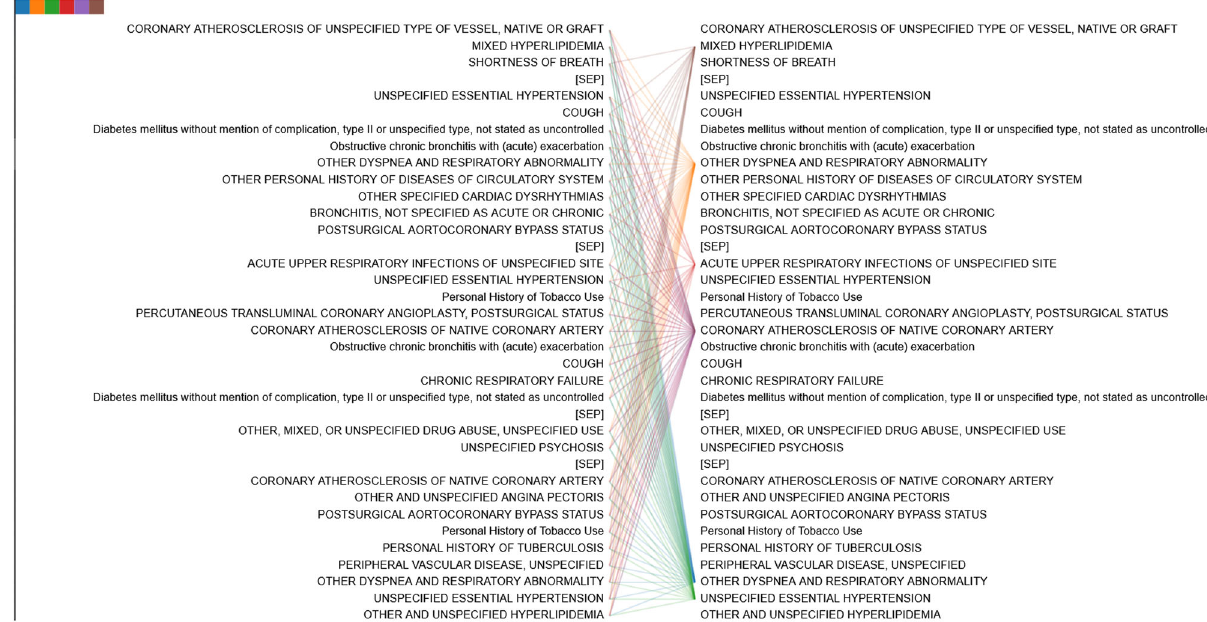
Fig. 6 Example of the dependency connections in the DHF-Cerner cohort. Connection lines from the code in the left panel to the code in the right panel indicate attentions of the Med-BERT model. Color of the line indicates individual attention head, and intensity of the line indicates attention weights.